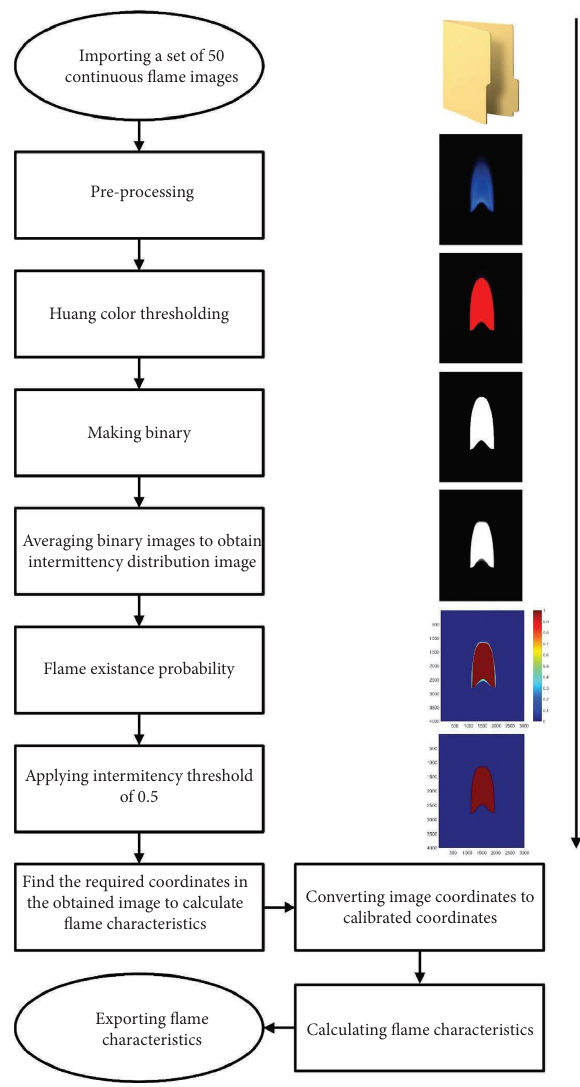
Figure 2: Procedure employed to calculate fame characteristics.